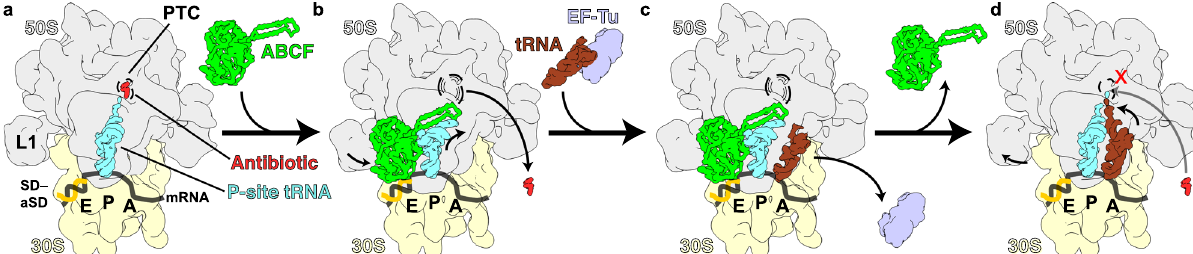
Fig. 7 Model for ribosome protection by ARE-ABCFs VmlR, LsaA, VgaA LC and VgaL. a PLS A -stalled ribosomes containing an initiator tRNA in the P-site are recognized by the ARE-ABCFs such as VmlR, LsaA, VgaA LC and VgaL, which bind to the E-site of the ribosome with a closed ATP-bound conformation. b Binding of the ARE-ABCF induces a shifted P-site tRNA conformation in the ribosome allowing the ARD of the ARE-ABCF to access the peptidyl transferase centre (PTC). The ARD induces conformational changes within the 23S rRNA at the PTC that promotes dissociation of the drug from its binding site (shown as dashed lines). c Aminoacyl-tRNAs can still bind to the ARE-ABCF-bound ribosomal complex, but cannot accommodate at the PTC due